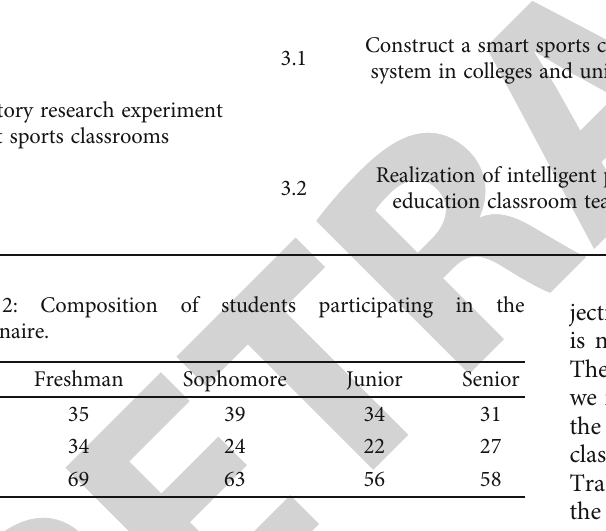
Figure 1: Part of the technical process of this method. Table 1: Experimental steps in this article.